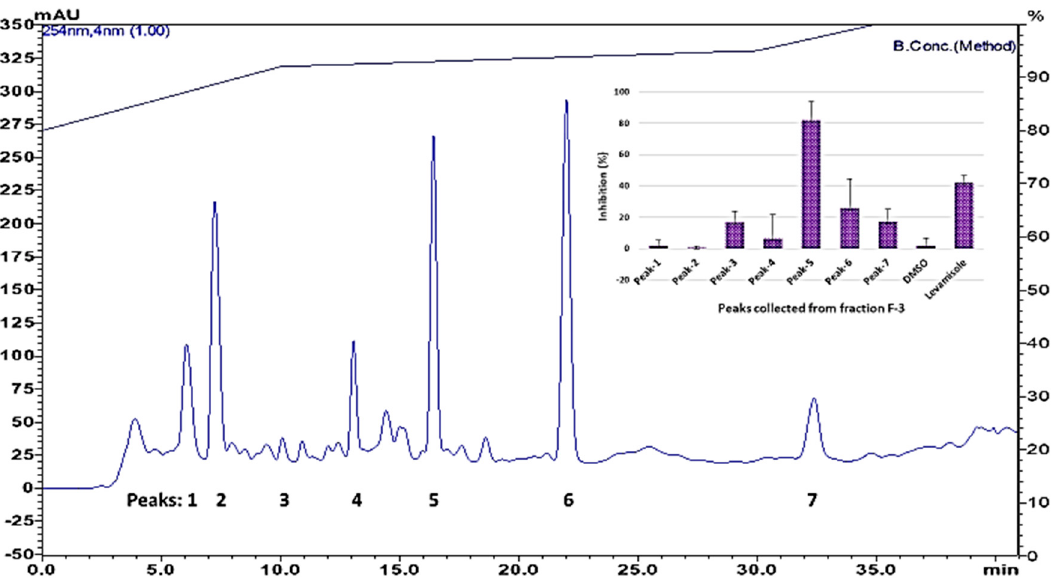
Figure 2. HPLC chromatogram of silica column fraction 3, and nematicidal activity of chromatographic peaks. Top right corner, data presented as nematicidal effects (activity based on movement of C. elegans detected by infrared microbeams) of individual peaks collected from HPLC.